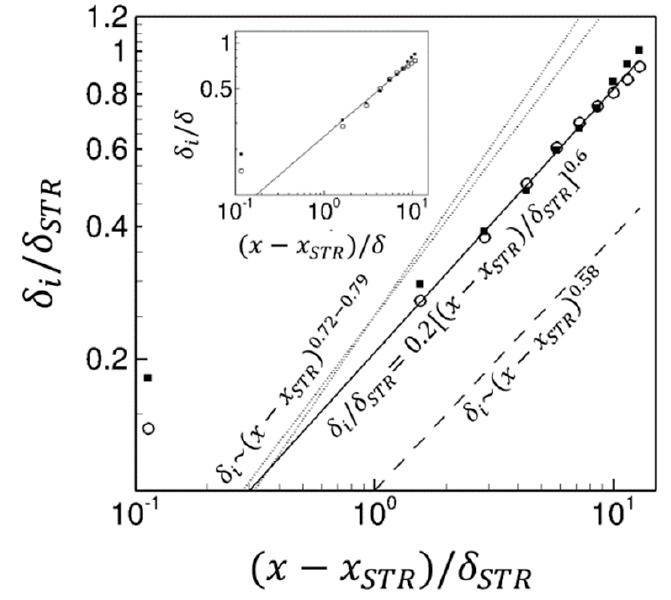
Figure 12. Growth of the internal layer δ i / δ STR along the fetch length ( x − x STR ) / δ STR . Figure 12 . Growth of the internal layer 𝛿 Open circles: estimate of δ i using U ; filled squares: estimate of δ i using ∂ U estimate of 𝛿 δ i / δ STR = 0.2 [( x − x STR ) / δ STR ] 0.6 ; dashed line: power law fit by with exponent being 0.58